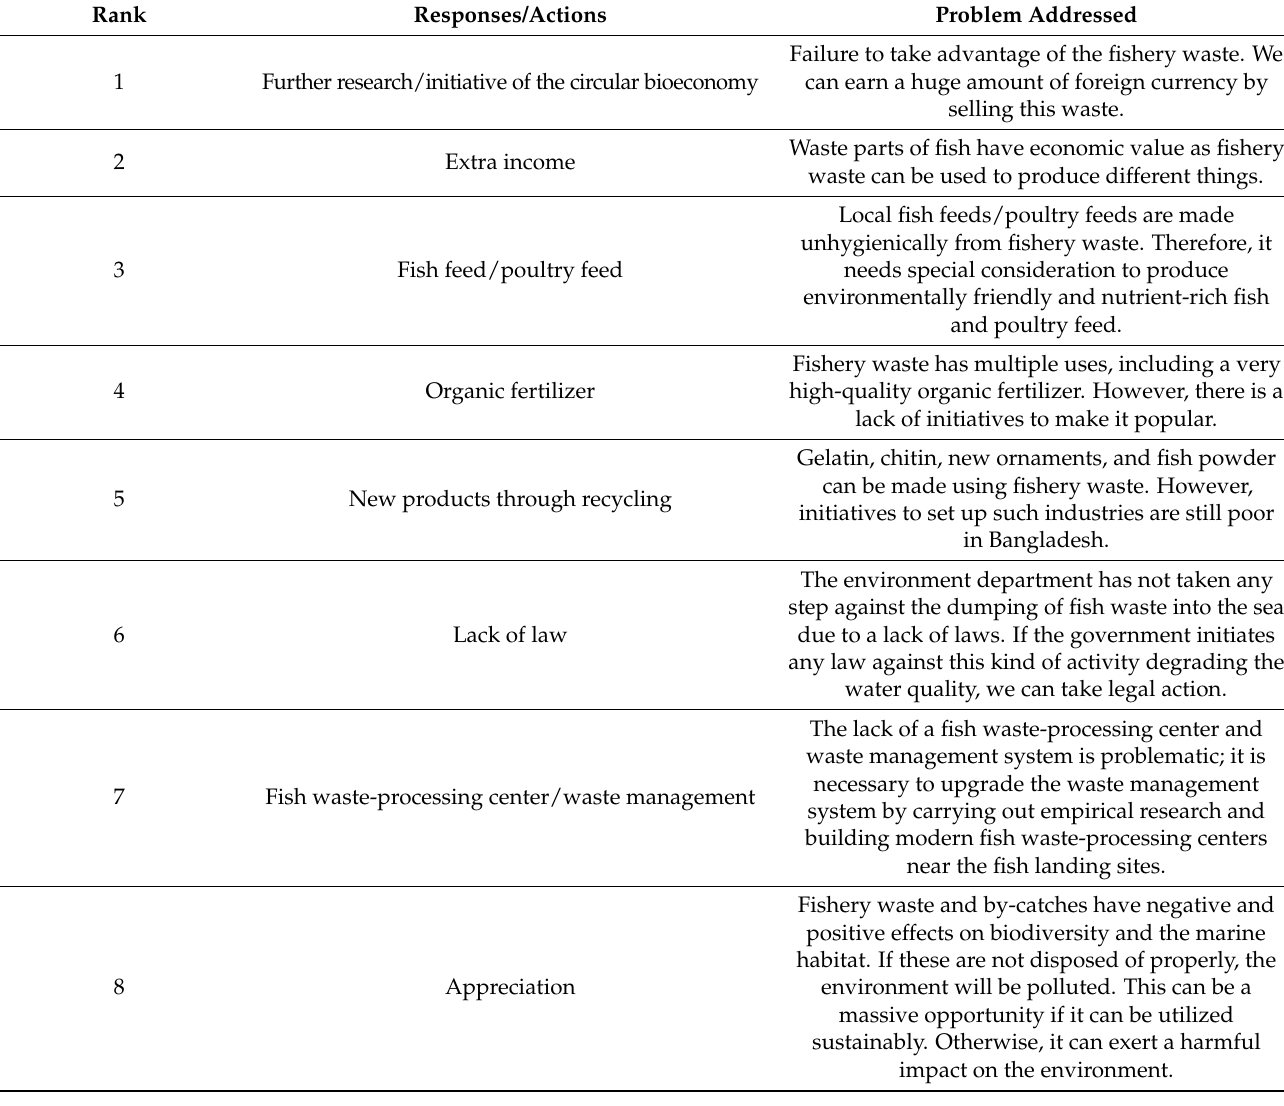
Table 4. Coping with the problems in the sustainable utilization of fishery waste in